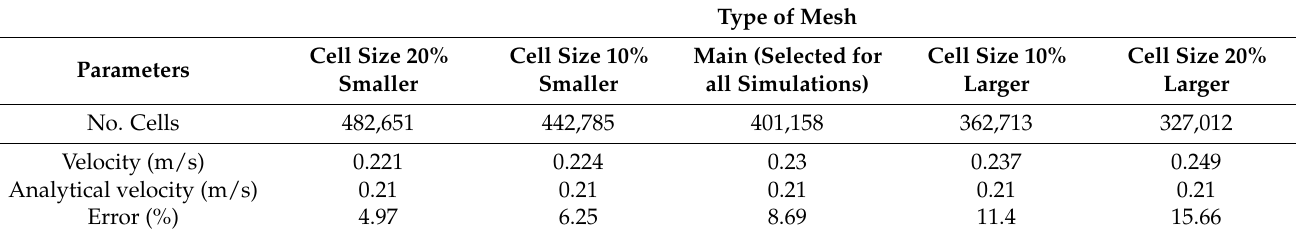
Table 2. Mesh accuracy and sensitivity analysis.